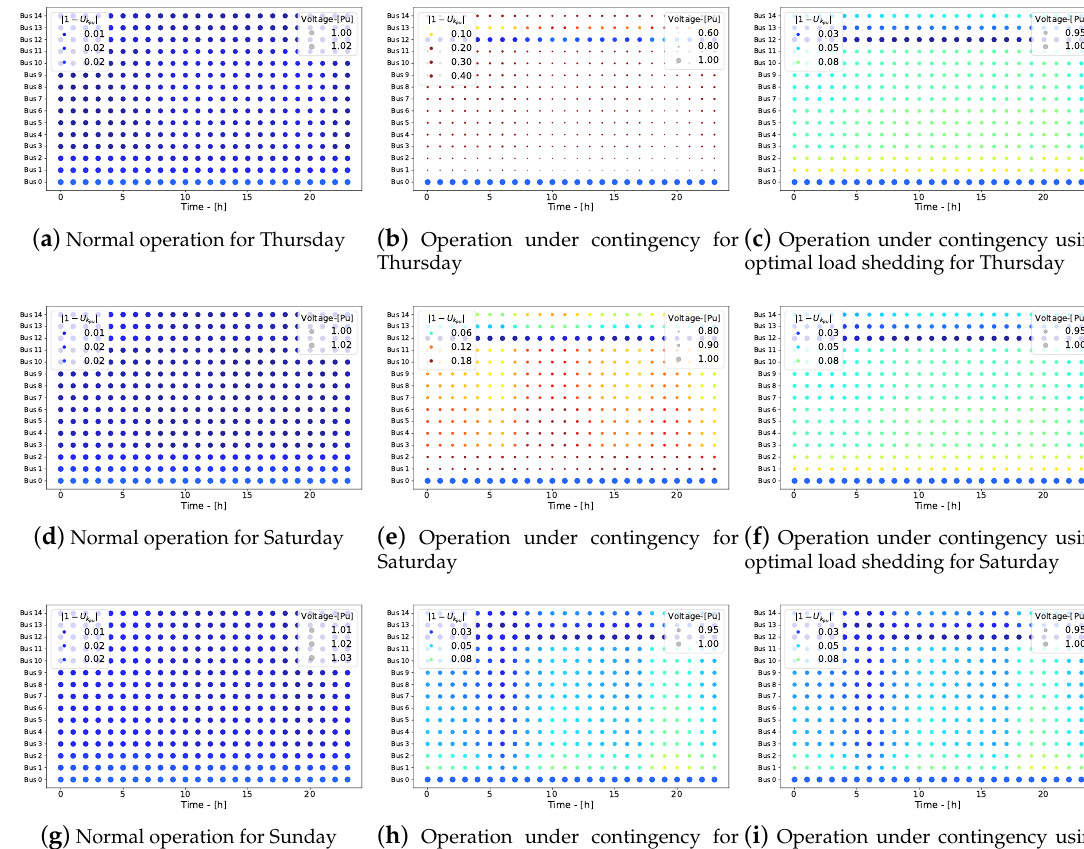
Figure 7. Bus voltages for different days and hours considering: the normal operation, a contingency when transformer Trafo 0-1 is out of service, and the results of load shedding using the proposed methodology for the same